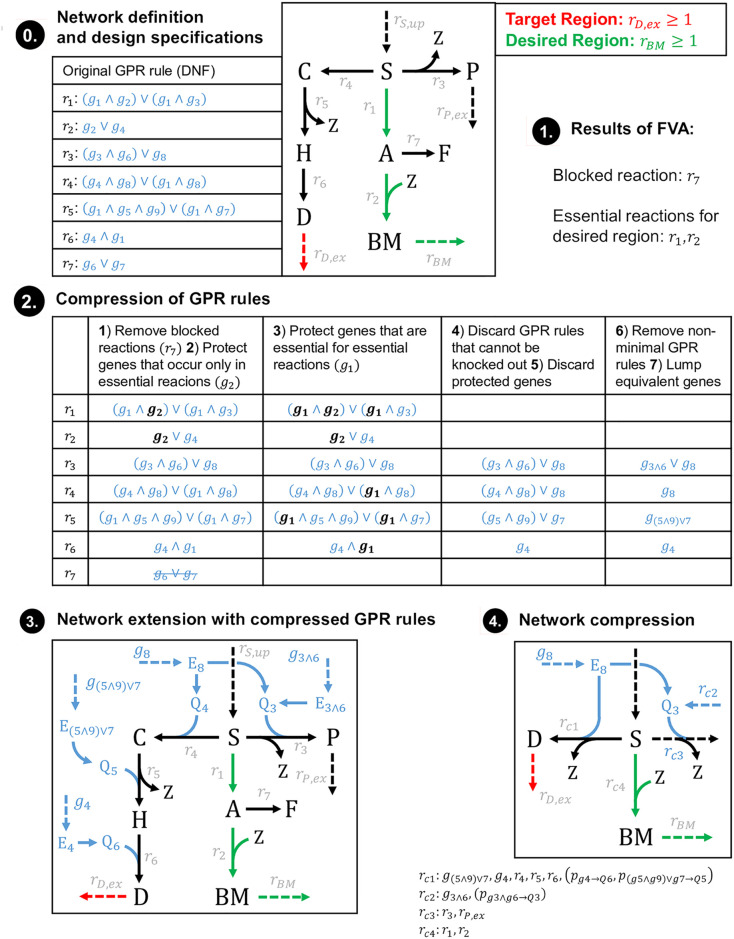
Example illustrating the 7 steps of gene MCS calculation.Red arrow: targeted reaction; green arrows: protected reactions; blue: GPR rules; dashed blue arrows: switchable gene pseudo-reactions. For the sake of readability, the protein pool pseudo-reactions (p) connecting the enzymes (E) with the enzyme pools (Q) were not labeled in the network in step 3 and 4. The reactions rc1 … rc4 represent lumped reactions resulting from network compression (the contained reactions are shown below the box of step 4). The subsequent steps 5–7 of this example are shown in Fig 5.